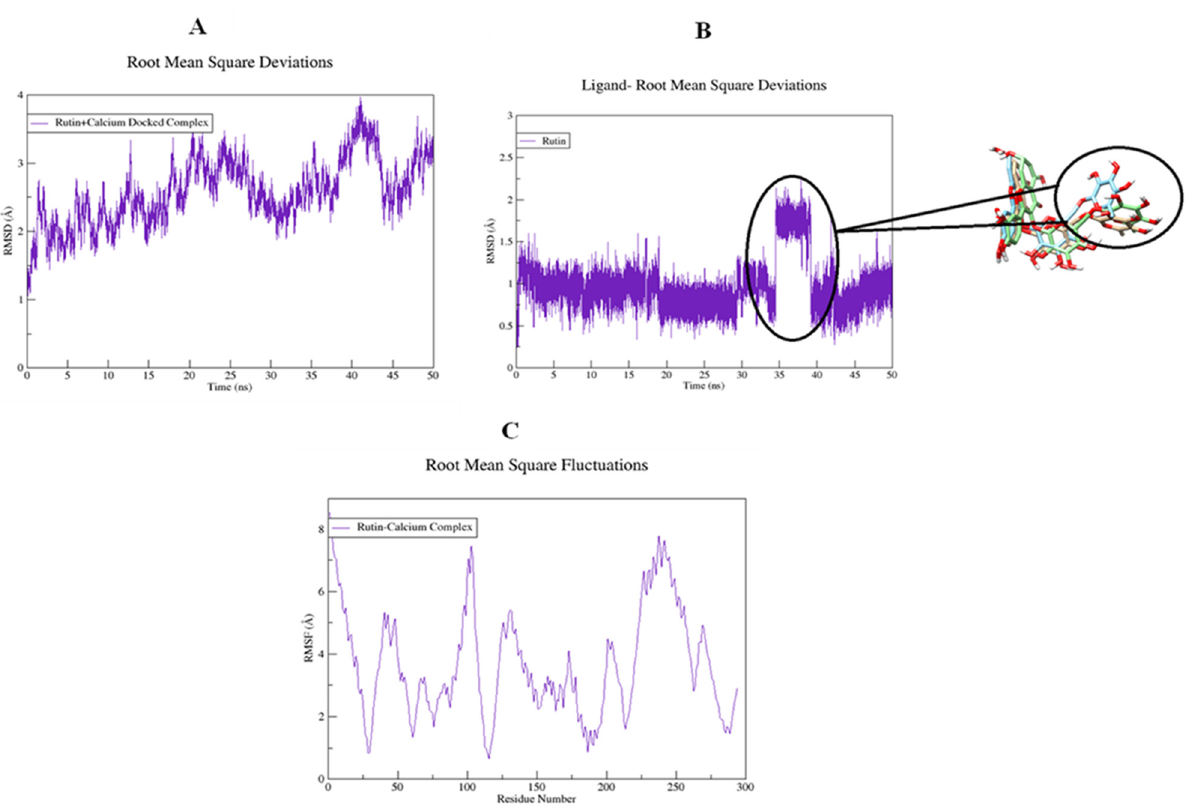
Figure 19. Root mean square deviations of backbone atoms of ( A ) rutin-voltage gated L-type calcium channel docked complex, ( B ) rutin, and ( C ) root mean square fluctuations of the backbone atoms of the rutin-voltage gated L-type calcium channel docked complex.